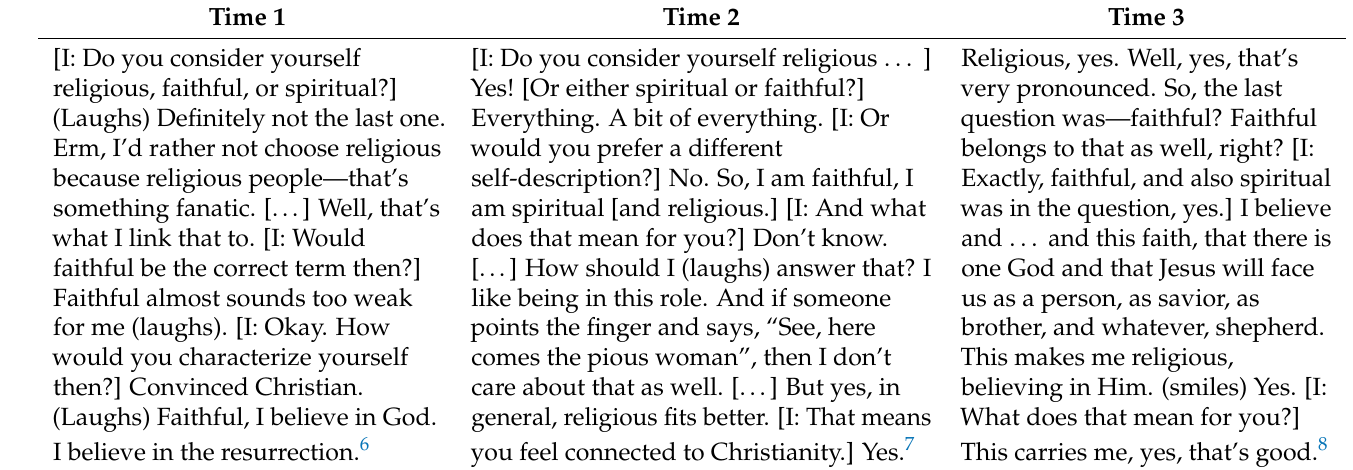
Table 1. Gudrun’s answers to Question 20: “Do you consider yourself a religious, spiritual, or faithful